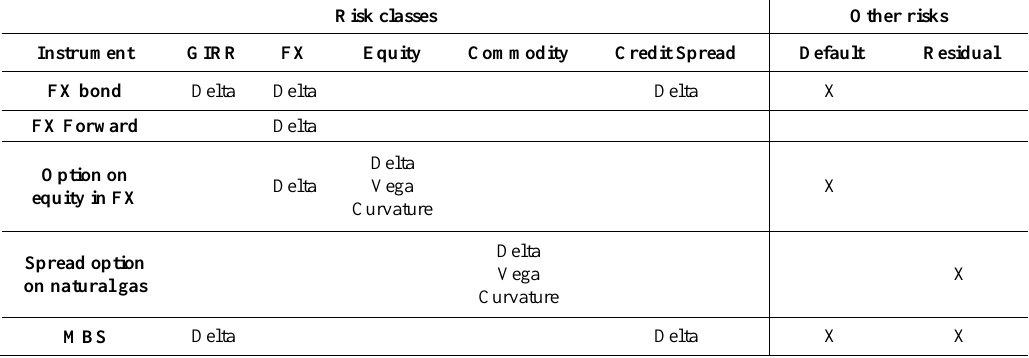
Table 5. The different risk classes according to the standardized approach.